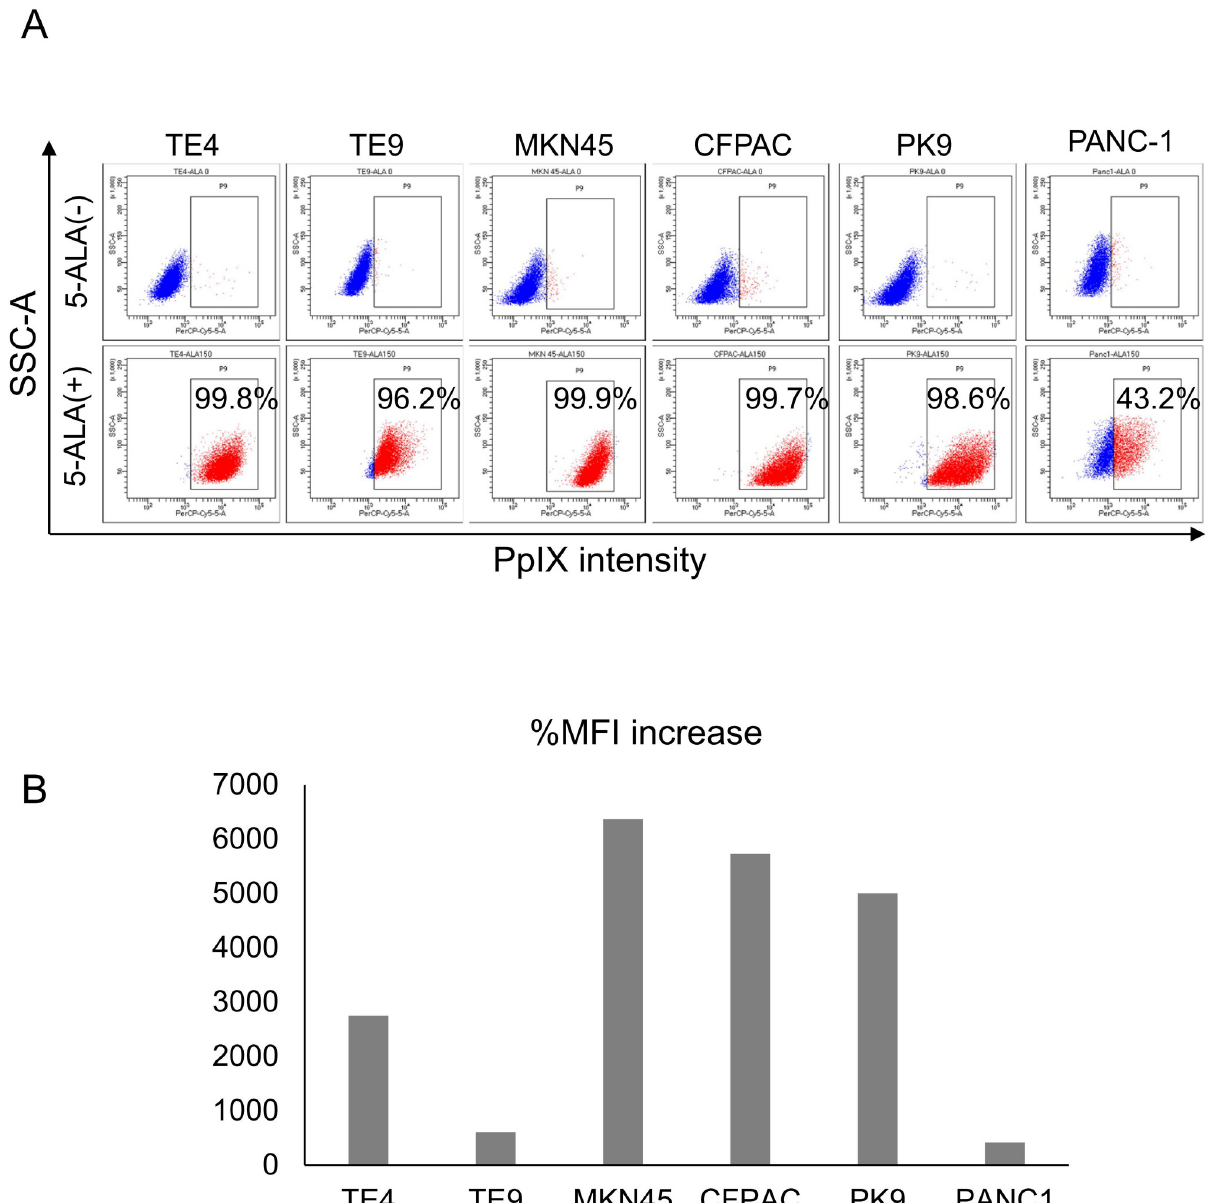
Fig 1. 5-ALA staining of gastrointestinal cancer cells. (A) FACS analysis of 5-ALA-stained gastrointestinal cancer cells. Esophageal cancer cells (TE4 and TE9), gastric cancer cells (MKN45), and pancreatic cancer cells (CFPAC, PANC-1, and PK9) were stained with 5-ALA (150 μ g/mL) for 4 h and analyzed by flow cytometry. Non-stained cells were used as negative controls. Percentages indicate the positive rates of PpIX intensity. (B) Summary of percent mean fluorescent increase (%MFI) .